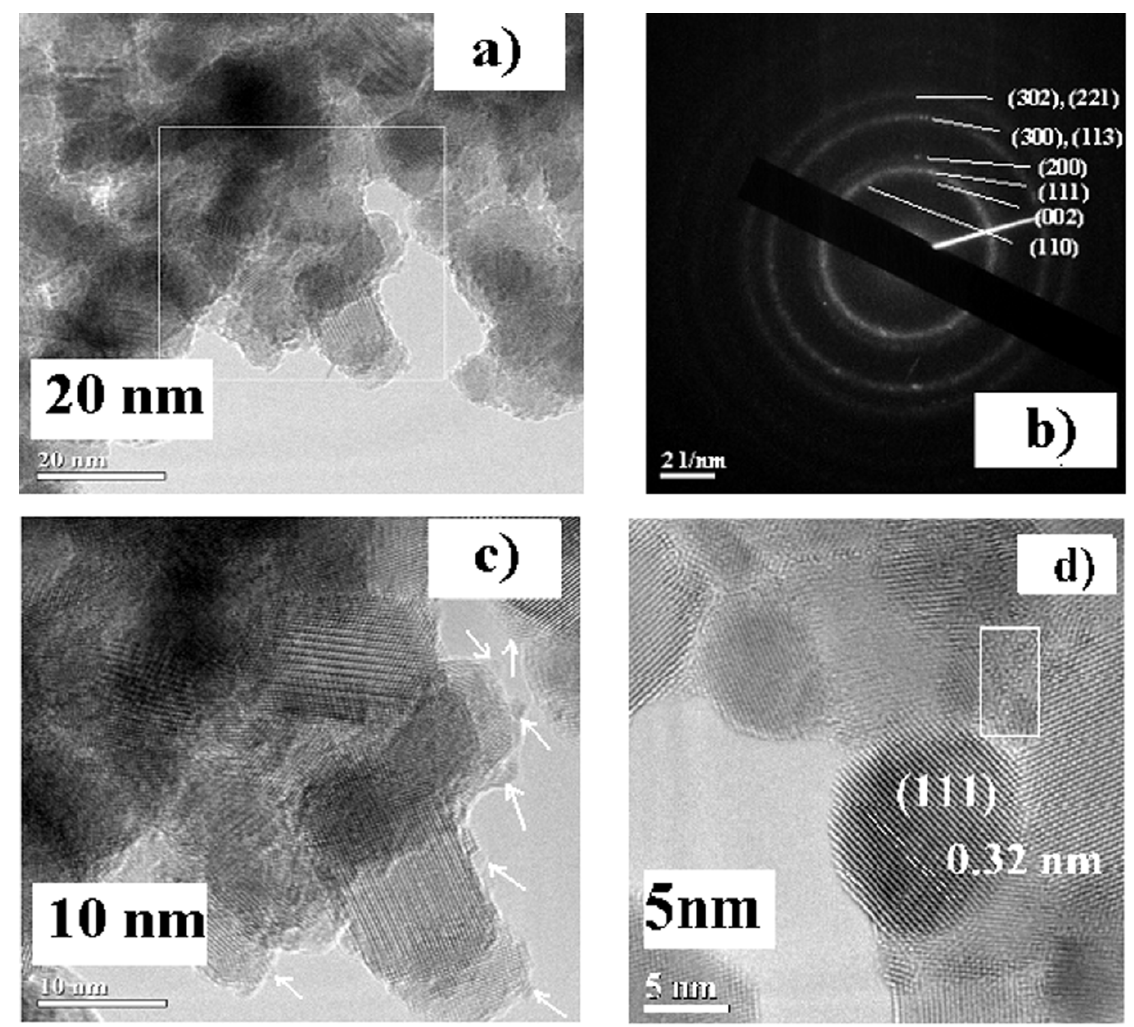
Figure 3. ( a ) TEM; ( c , d ) HRTEM images and ( b ) SAED (selected-area electron diffraction pattern) pattern of CeF 3 nanoparticles. The area highlighted by a white rectangle in Figure 3a is shown in Figure 3c. The amorphous area of the sample in Figure 3d is marked with a white rectangle [12].